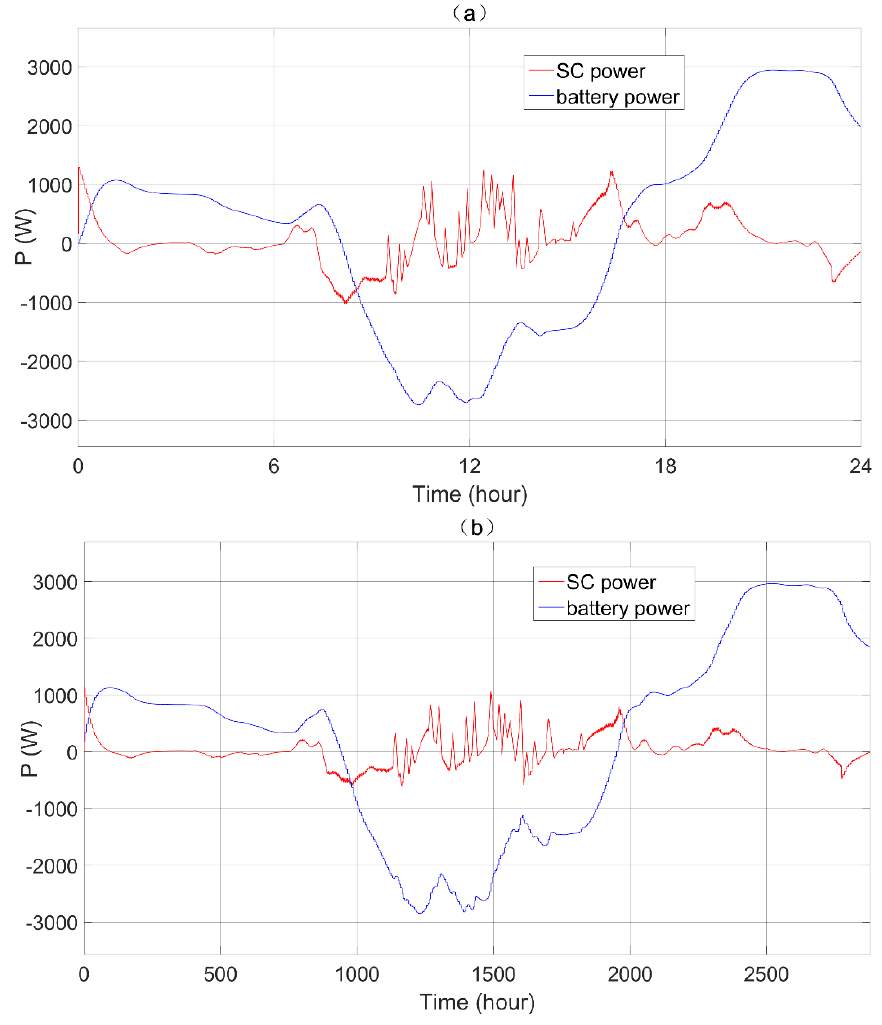
Figure 22. ( a ) Hybrid energy storage power distribution operation result of CPS-based hybrid energy storage multi-objective optimization control strategy and ( b ) traditional low-pass filter control.